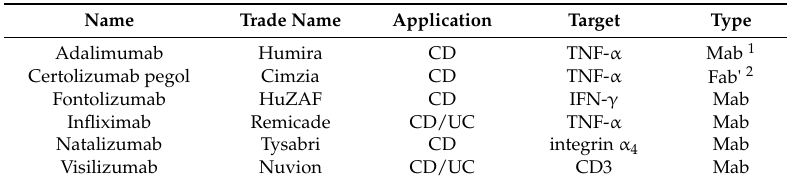
Table 1. List of therapeutic monoclonal antibodies used for IBD